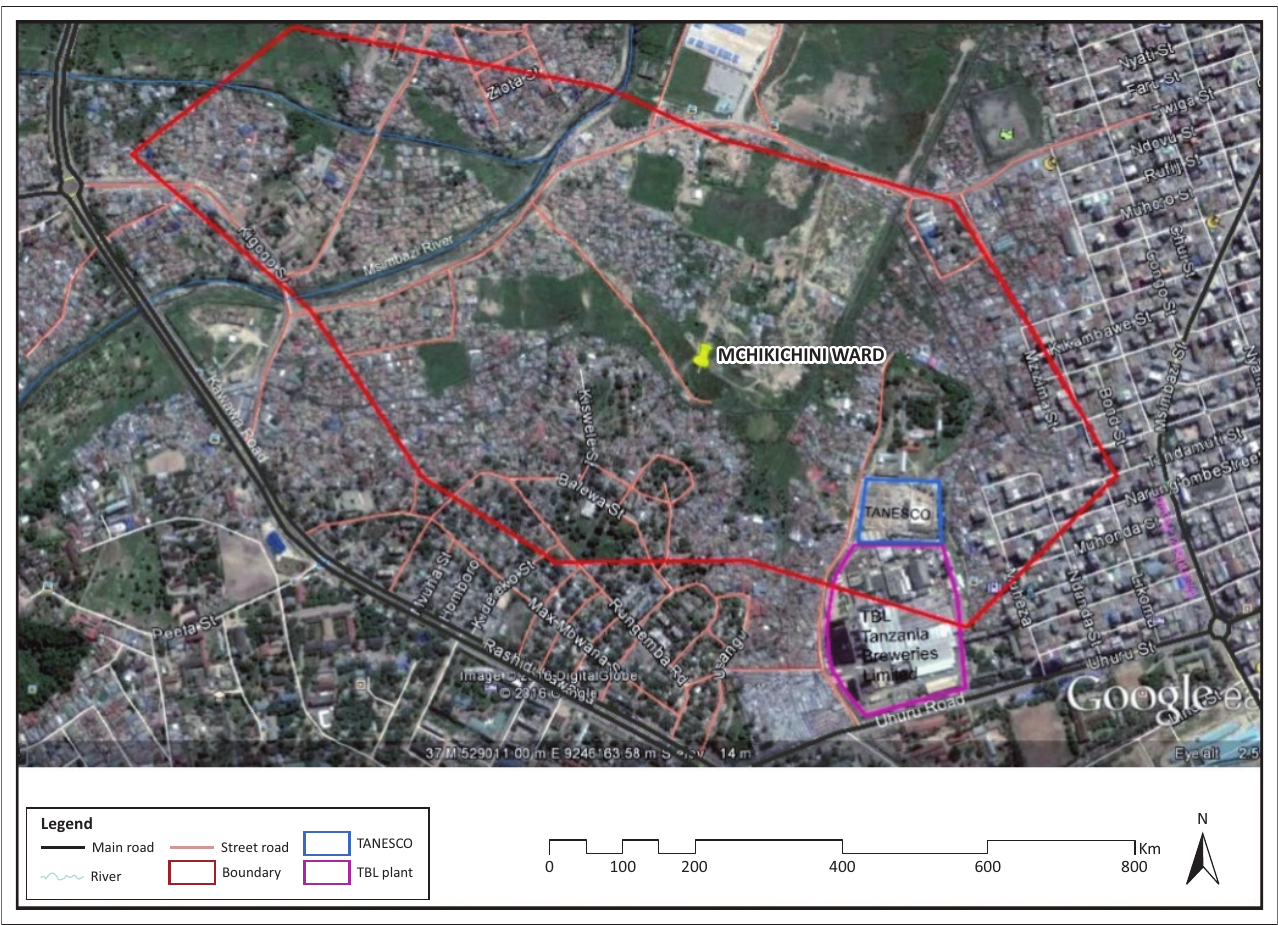
FIGURE 2: Accessibility and physical development in Mchikichini